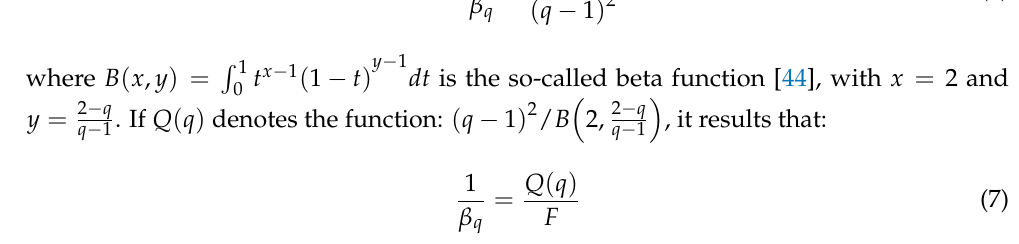
Table 1. The entropic and mechanical parameters during the UC experiment for each consequent AE hit